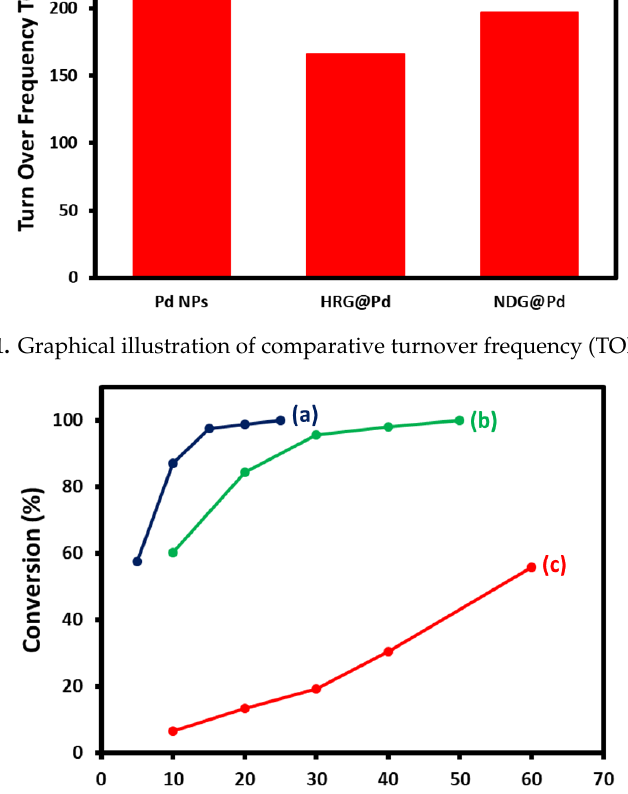
Figure 13. Comparison study of time-dependent conversion efficiency of the Suzuki reaction employing ( a ) NDG@Pd and ( b ) HRG@Pd nanocatalysts for iodobenzene with phenylboronic acid under aqueous and aerobic conditions (determined by GC analysis). A recyclability study of the prepared nanocatalyst, i.e. NDG@Pd, was carried out in order to check the stability of the catalyst, and it was found that activity marginally reduced upon consequent use. The formation of a Suzuki-coupled product reduced from 100% to 91% after four times of use. In order to ascertain the reason, the reaction mixture was subjected to Inductively coupled plasma mass spectrometry (ICP-MS) analysis. Upon analysis, it was found that the reaction mixture contained 69 ppb of Pd metal, which indicated that there was a minuscule leaching of Pd metal, which